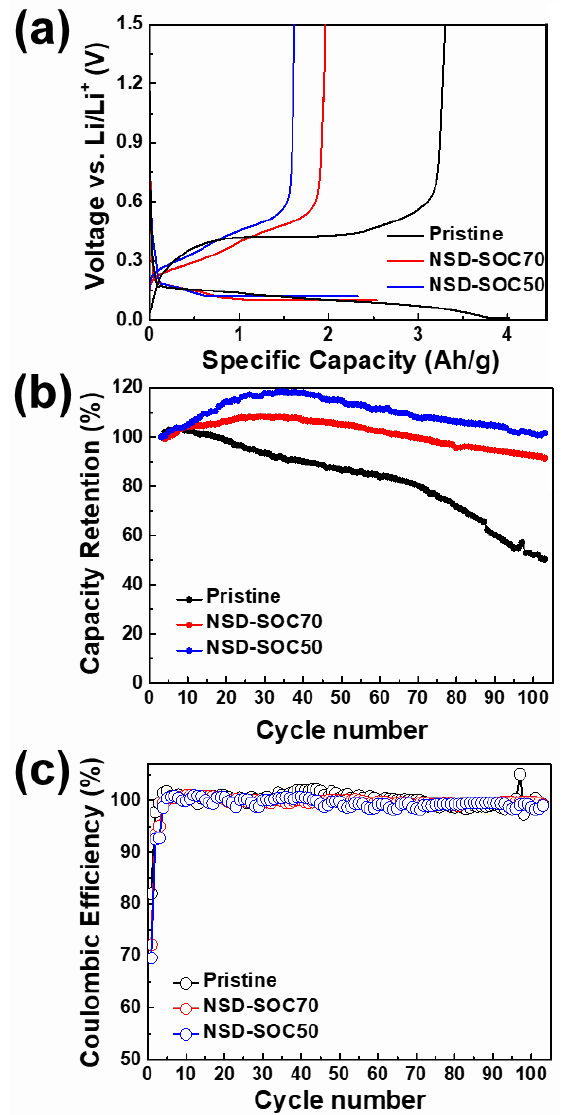
Figure 2. Electrochemical performances of NSD electrodes with different utilization degrees. ( a ) Initial cycle voltage profiles at 0.1 C, ( b ) cycle retention at 0.5 C and ( c ) Coulombic efficiency at 0.5 C.